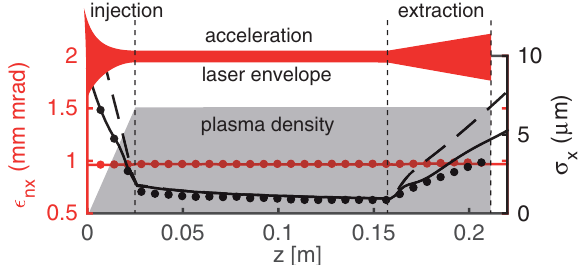
FIG. 4. Comparison of the 3D A STRA run as shown in Fig. 2(a) (dashed line) and a 2D PIC run (dots). The dashed black line shows the beam size evolution according to the 3D wakefield model in A STRA . For comparison, the solid black line corre- sponds to an A STRA simulation employing the same 2D laser model as the PIC simulation.